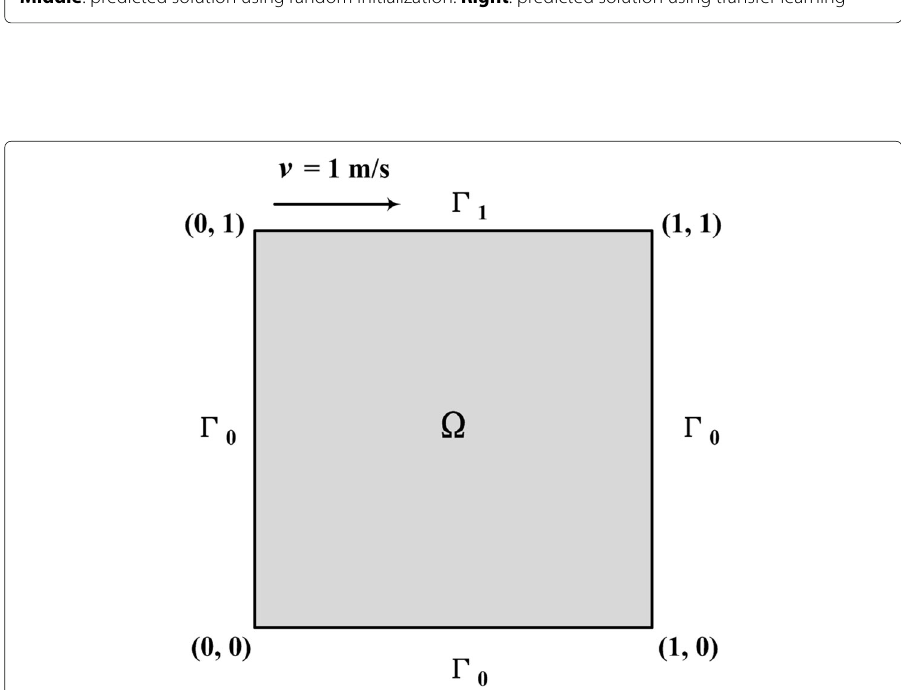
Fig. 5 Two-dimensional lid-driven cavity